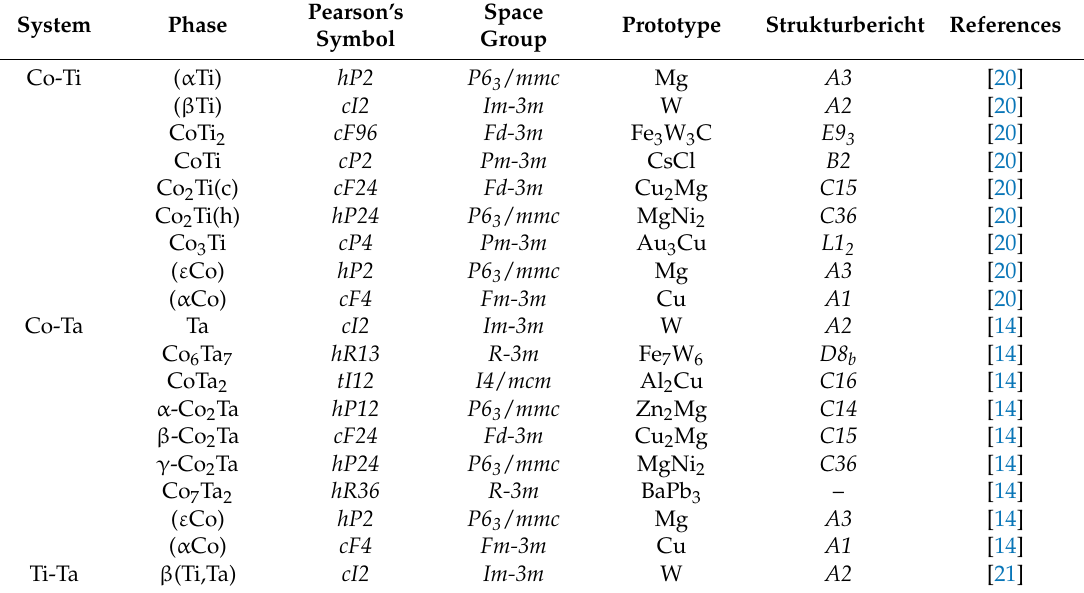
Figure 1. Binary phase diagrams constituting the Co-Ti-Ta ternary system [14,20,21]. Table 1. The stable solid phases in the Co-Ti-Ta ternary system.